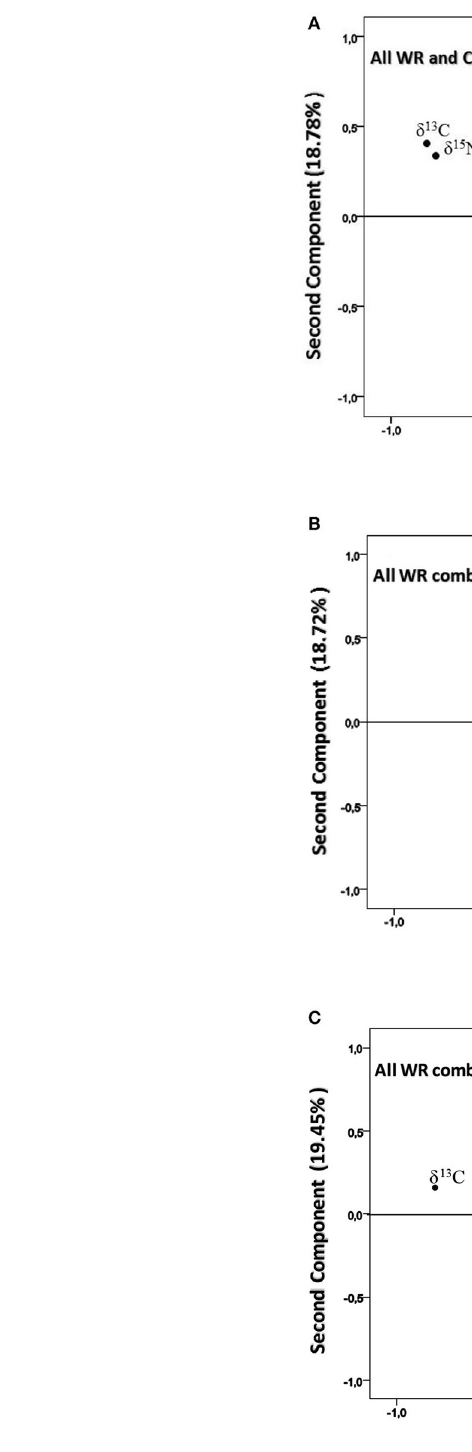
Frontiers in Plant Science | www.frontiersin.org